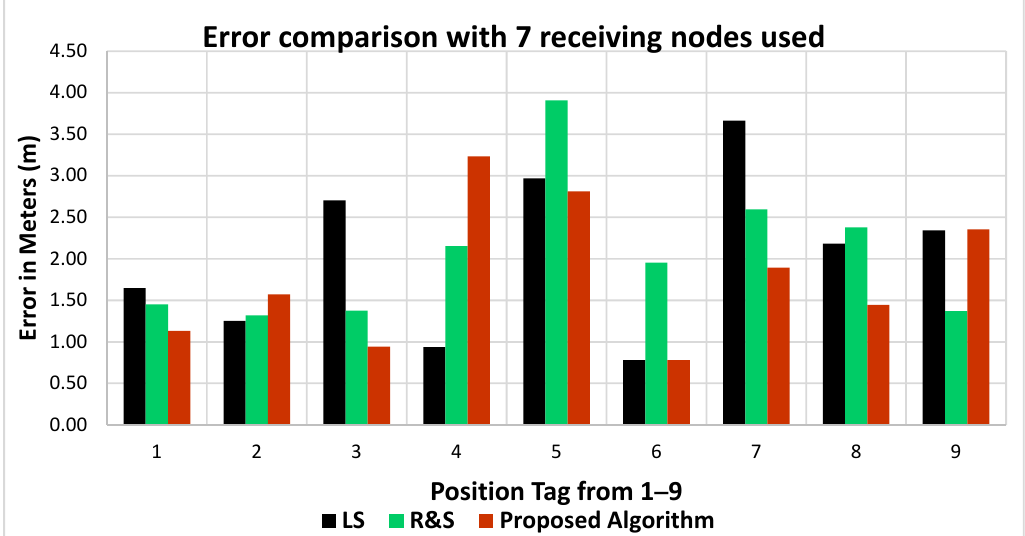
Figure 11. Error comparison with seven measurement sensors used.